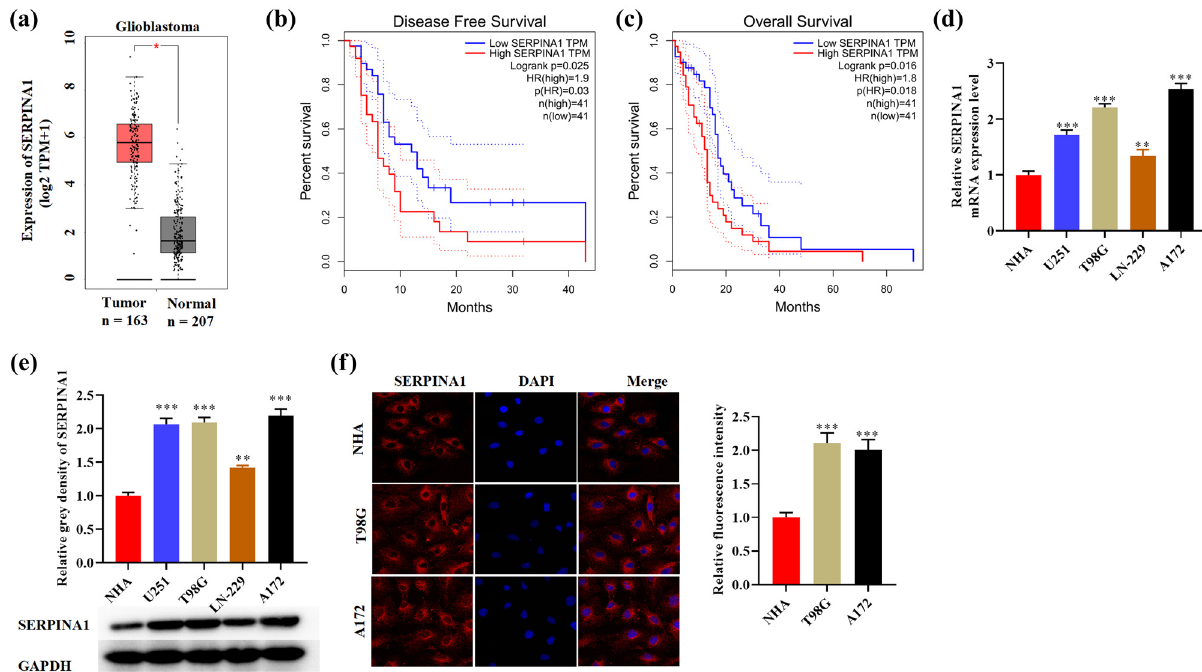
Figure 1: SERPINA1 is upregulated in glioma. ( a ) Di ff erential expression of SERPINA1 in glioblastoma ( box plot ) ( red: tumor tissue, gray: normal tissue ) . ( b and c ) Kaplan – Meier survival curves of disease - free survival and overall survival of patients who had gliomas with di ff erential expression of SERPINA1 . ( d and e ) qRT - PCR analysis of SERPINA1 mRNA expression and western blotting analysis of SERPINA1 protein in NHA, U251, T98G, LN - 229, and A172 cell lines. One - way ANOVA was conducted. ( f ) Co - staining of SERPINA1 ( red ) with DAPI ( blue ) in NHA, T98G, and A172 cell lines. One - way ANOVA was conducted. Data are expressed as means ± SEM ( * p < 0.05; ** p < 0.01; *** p < 0.001, n = 3 )